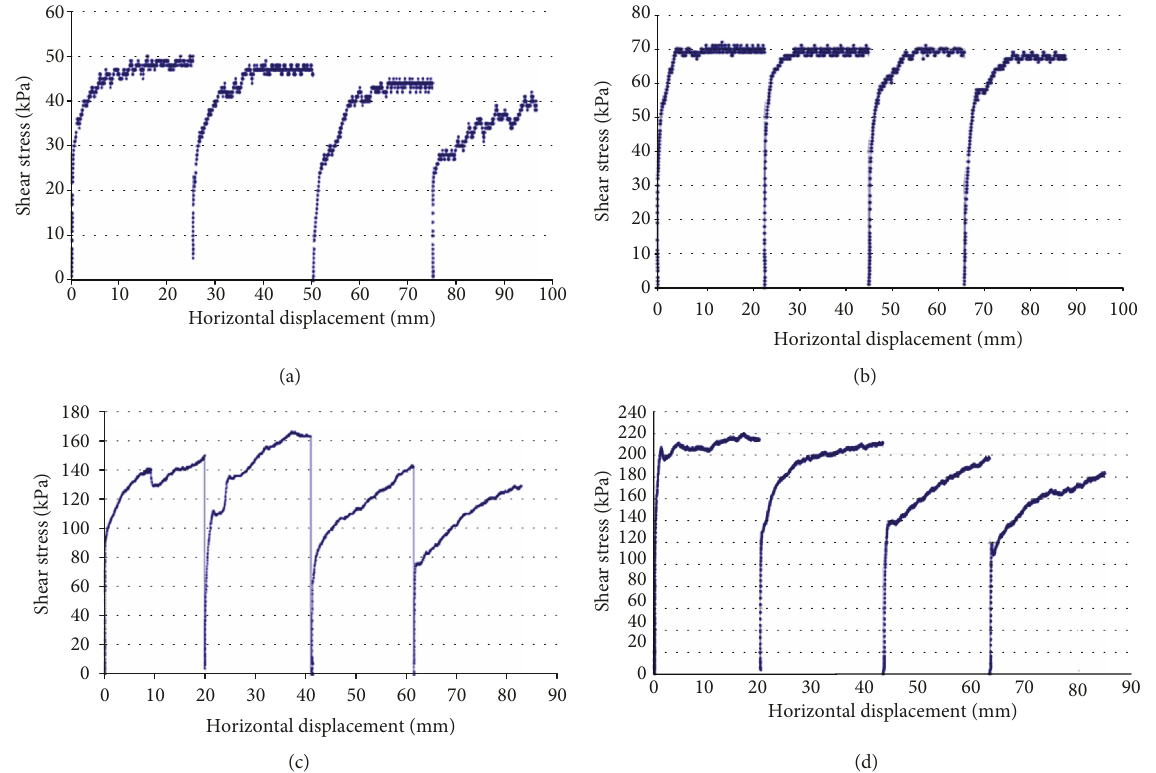
Figure 4: The shear stress-displacement curve of repeated direct shear at di ff erent normal stresses. (a) 60 kPa, (b) 110 kPa, (c) 260kPa, and (d) 410 kPa.